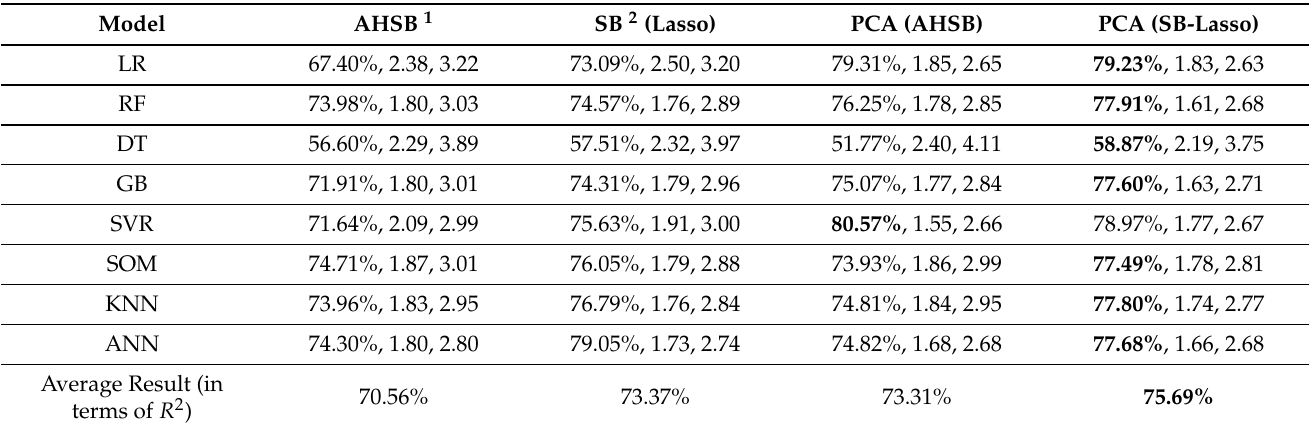
Table 4. Regression results ( R 2 , MAE , RMSE ) of different ML models for predicting nitrogen content. The bold values represent the best results considering different ML models.